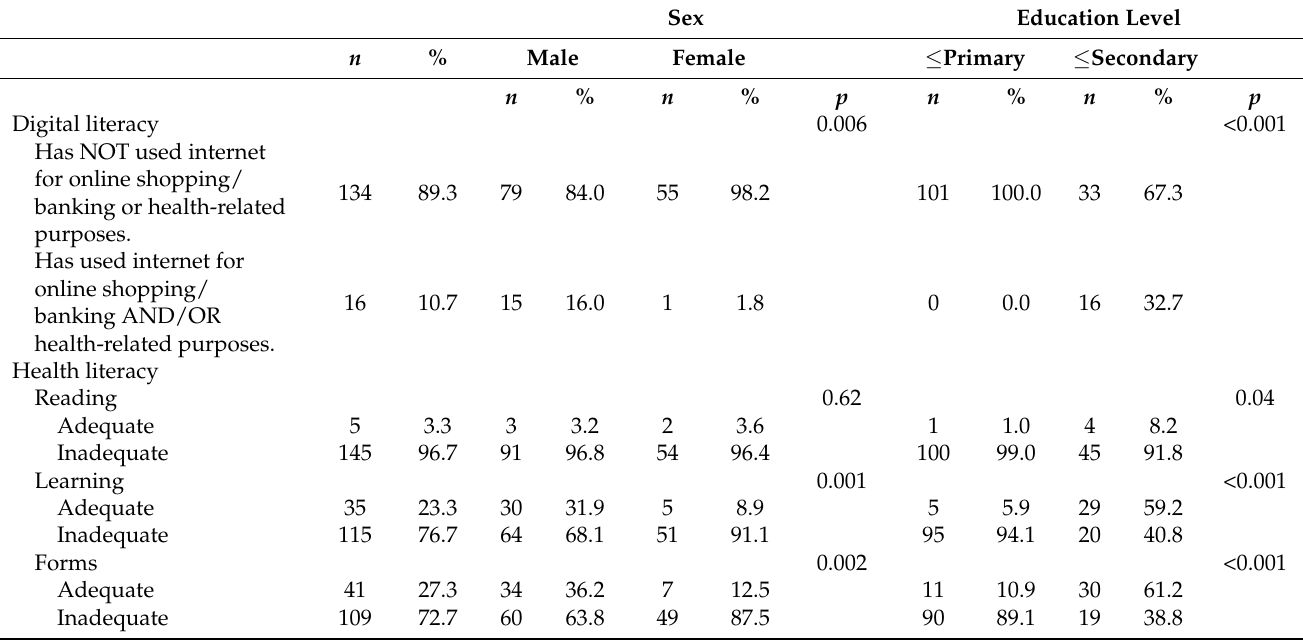
Table 3. Participants’ digital and health literacy levels.